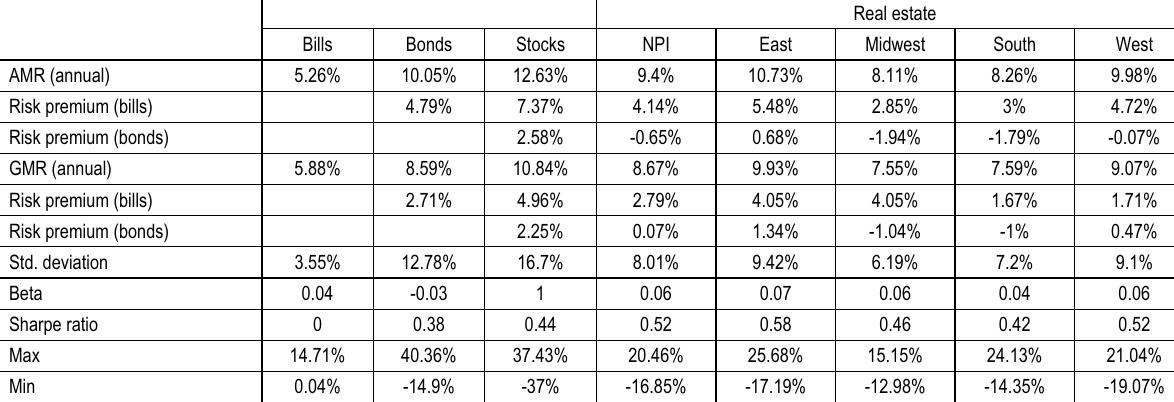
Table 1. Summary statistics – bills, bonds, stocks and real estate, 1978-2012 This Table gives the arithmetic mean return (AMR), geometric mean return (GMR), standard deviation, beta and sharpe ratio for bills (T-bills), bonds (T-bonds), stocks (S&P 500) and real estate. Except for the East region, real estate indices all have lower returns than bonds or stocks, but they all have lower standard deviations than either bonds or stocks. The Sharpe ratio shows that, over the study period, diversified real estate in East produced the highest reward per unit of standard deviation. Stocks had the highest average return, but they also have the most volatililty.